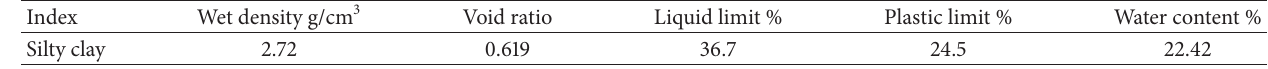
Table 1: Physicomechanical indexes of the soils of silty clay.